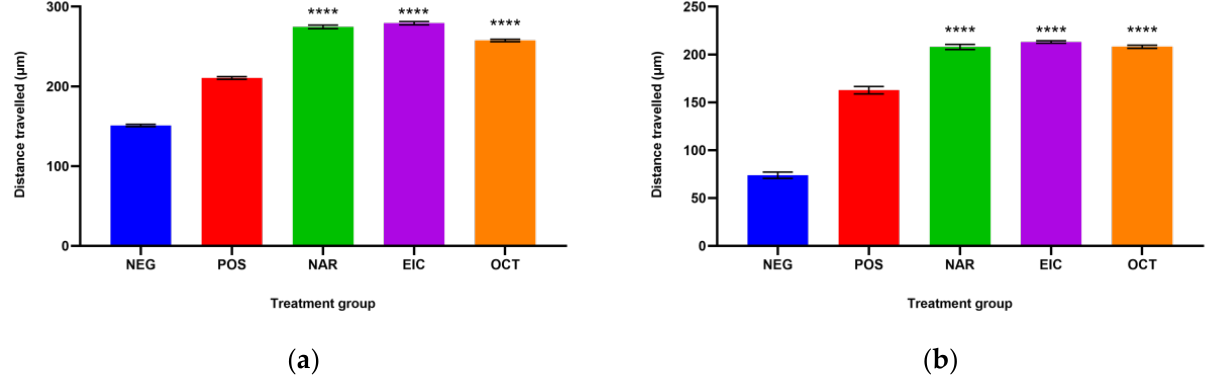
Figure 1. The total distance travelled by ( a ) normal HDF cells and ( b ) insulin-resistant HDF cells with different treatment groups. **** p < 0.0001 against the negative control group.